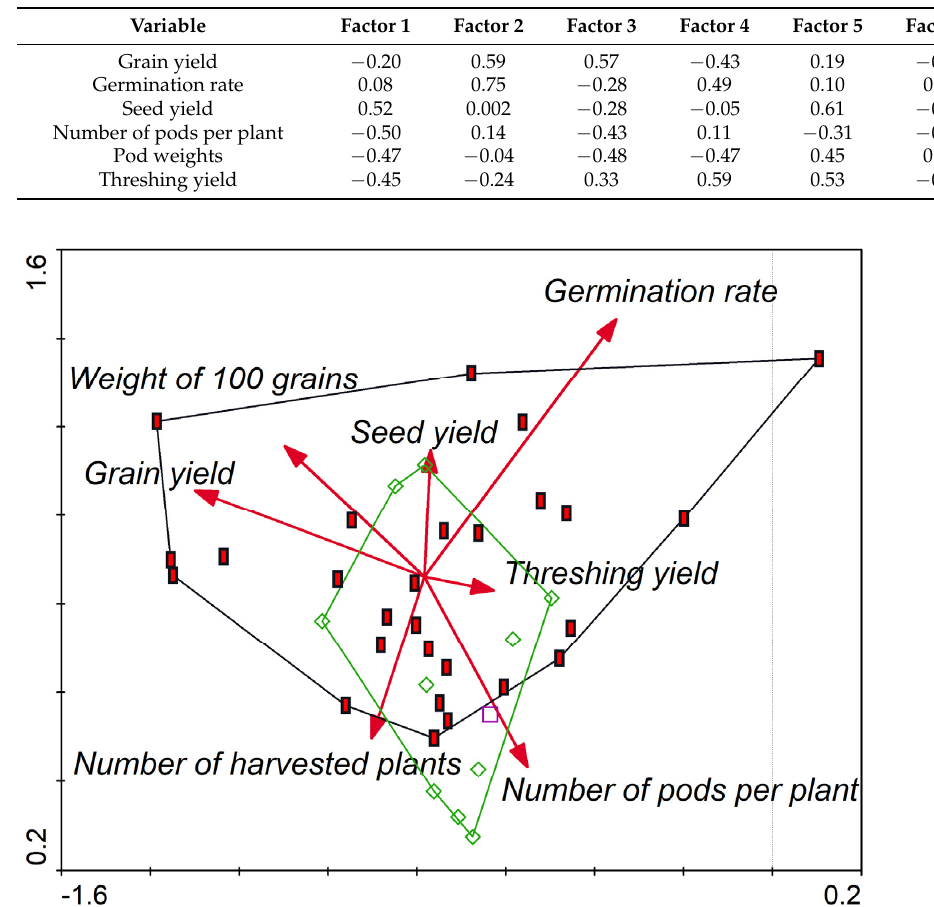
Table 3. Eigenvectors computed by PCA.